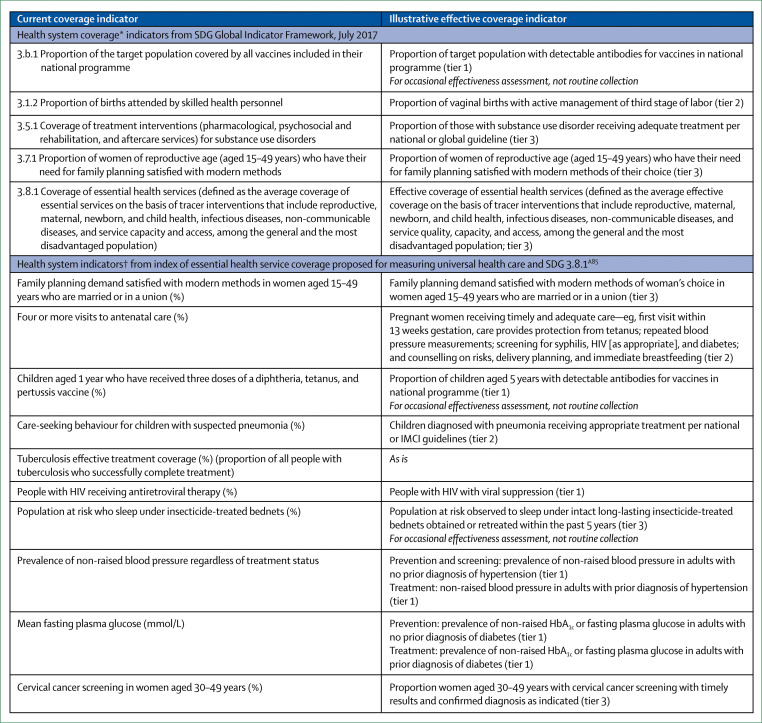
Illustrative indicators for advancing Sustainable Development Goal (SDG) monitoring from coverage towards effective coverageTier 1=priority action is implementation (routine or targeted, as for immunisation). Tier 2=priority action is determining efficiency in indicators and data collection. Tier 3=priority action is development of valid indicators for use at scale. IMCI=Integrated Management of Childhood Illness. *Excludes health indicators focusing on population outcomes alone. †Six indicators not shown: two primarily measuring determinants outside the health system (tobacco use and access to basic household sanitation) and four service capacity and access indicators. References can be found in appendix 1.